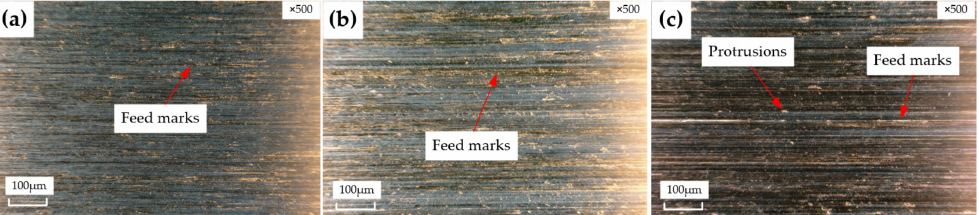
Figure 7. Surface morphologies reamed by Tool A with KEYENCE microscope, ( a ): v = 60 m/min, f = 0.4 mm/rev; ( b ): v = 60 m/min, f = 0.5 mm/rev; ( c ): v = 60 m/min, f = 0.6 mm/rev.